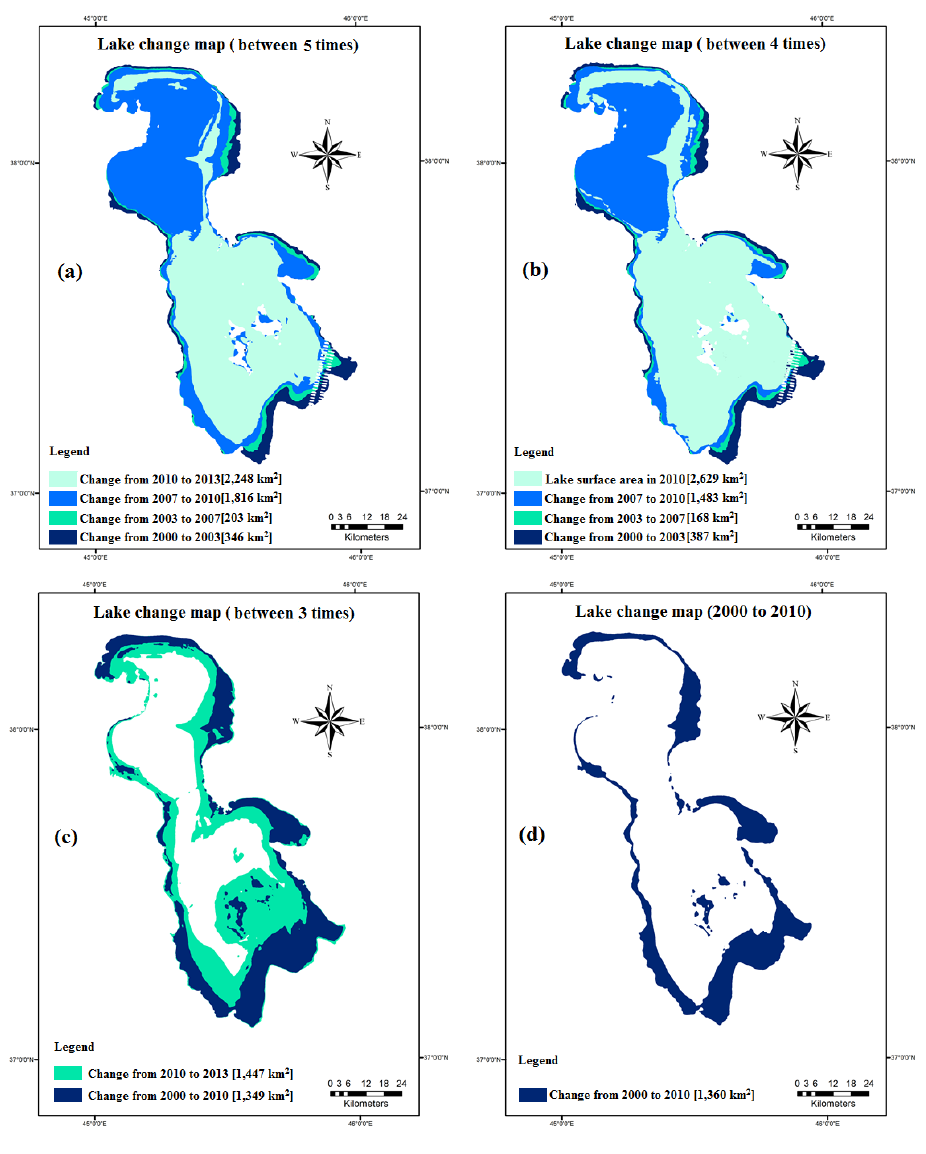
Figure 4. Lake Urmia surface area change maps, between ( a ) five, ( b ) four, ( c ) three, and ( d ) two different times, generated using the NDWI-PCs